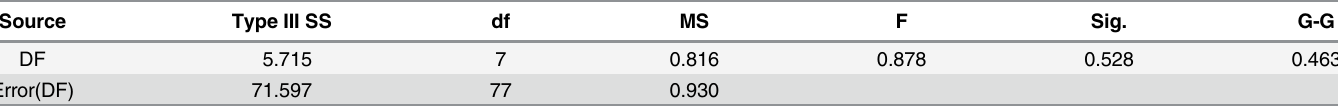
Table 5. One-way repeated measures ANOVA for the measure η with Δ f as a factor (eight conditions) see Fig 9C. Analysis shows that effect of Δ f on η does not reach significance. Mauchly test for sphericity reaches significance, Greenhouse-Geisser corrected P -value reported in the text. Data for N = 12 sub- jects, see